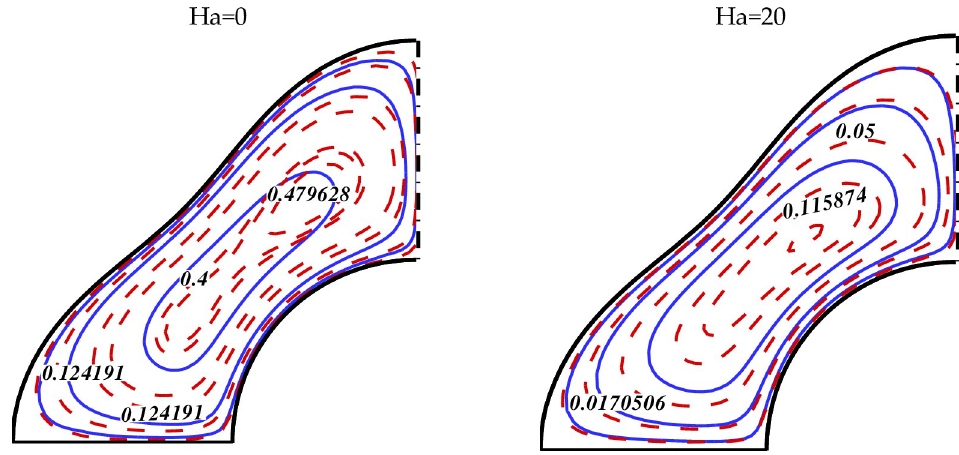
Fig 3. Effect of Da on nanofluid behavior ( Da = 100 (––) and Da = 0 . 01 (---)) when Ra = 10 3 , Rd = 0 . 8 .